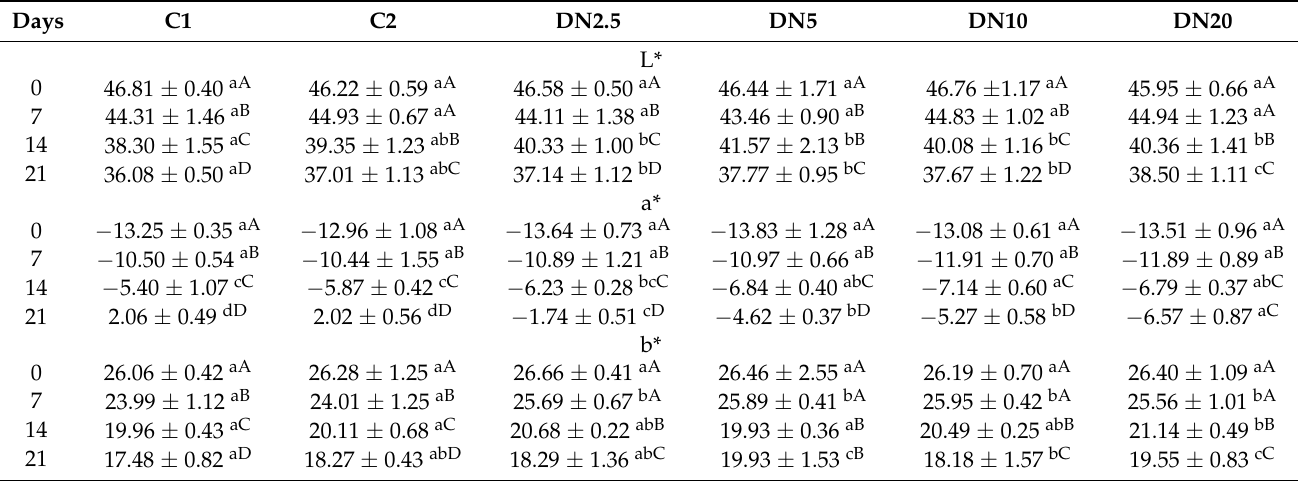
Figure 2. Firmness in tomato fruits coated with nanoemulsion during storage at 6 °C. Table 1 presents the results regarding the external colour of the tomato fruits, obtaining significant differences ( p < 0.05) in all the evaluated parameters. A decrease was observed in the L* parameter with respect to the storage time for all treatments because the fruit became darker owing to the accumulation of carotenoids. Further, a significant decrease ( p < 0.05) was observed in parameter a* (green to red) for all the treatments after 21 days. The controls (C1 and C2) already exhibited positive values, which indicated the rapid maturation of the fruits, on the last day of the evaluation, while the nanoemulsion–coated ones exhibited negative values that indicated their late maturation. Similarly, the b* parameter (blue to yellow) also decreased mainly in uncoated fruits (C1), indicating rapid maturation, as in the other colour parameters. Table 1. External color of tomato fruits coated with nanoemulsion during